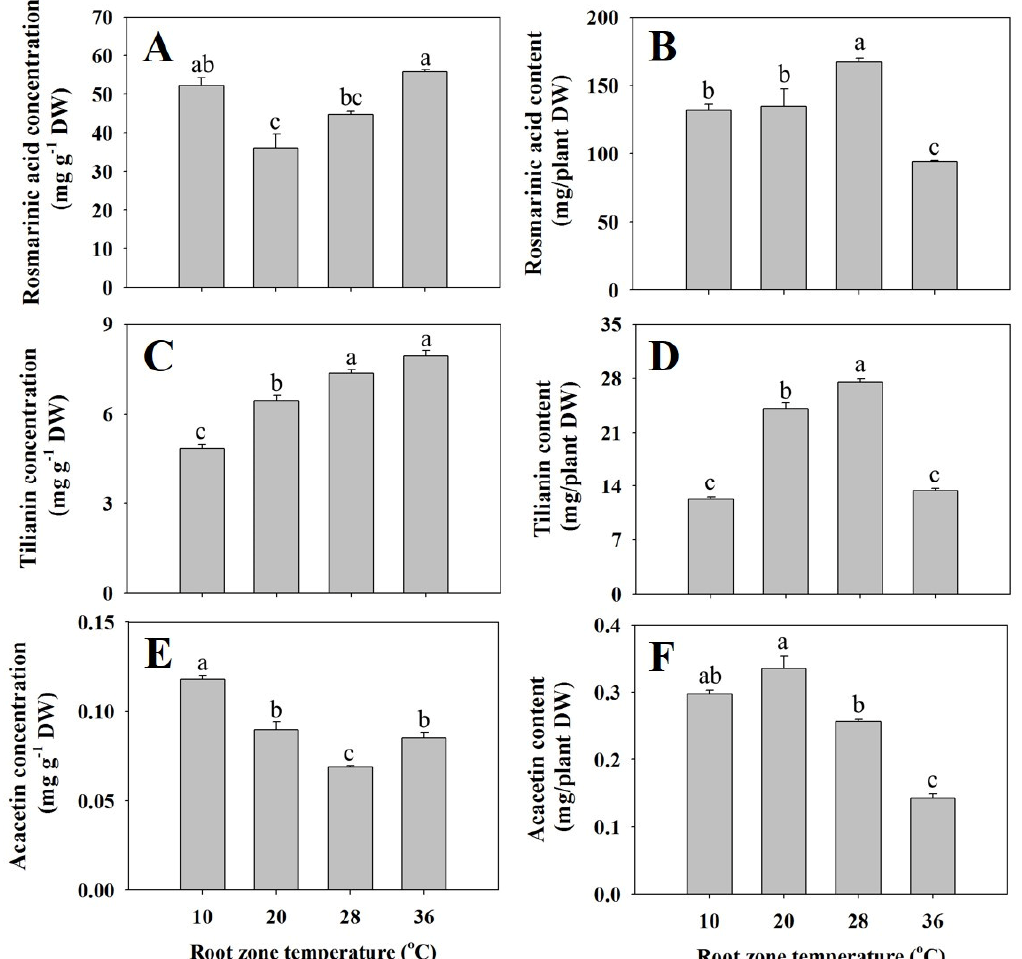
Figure 5. Rosmarinic acid (RA) ( A and B ), tilianin ( C and D ), and acacetin ( E and F ) concentrations and contents in the whole plant of A. rugosa at four different root zone temperature (RZT) treatments (10, 20, 28, and 36 °C) at 32 days after transplant. Data are shown as the means ± standard error (SE) (n = 3). Different letters (a-c) show significant differences among the RZT treatments (Tukey’s test, p < 0.05). DW: dry weight.